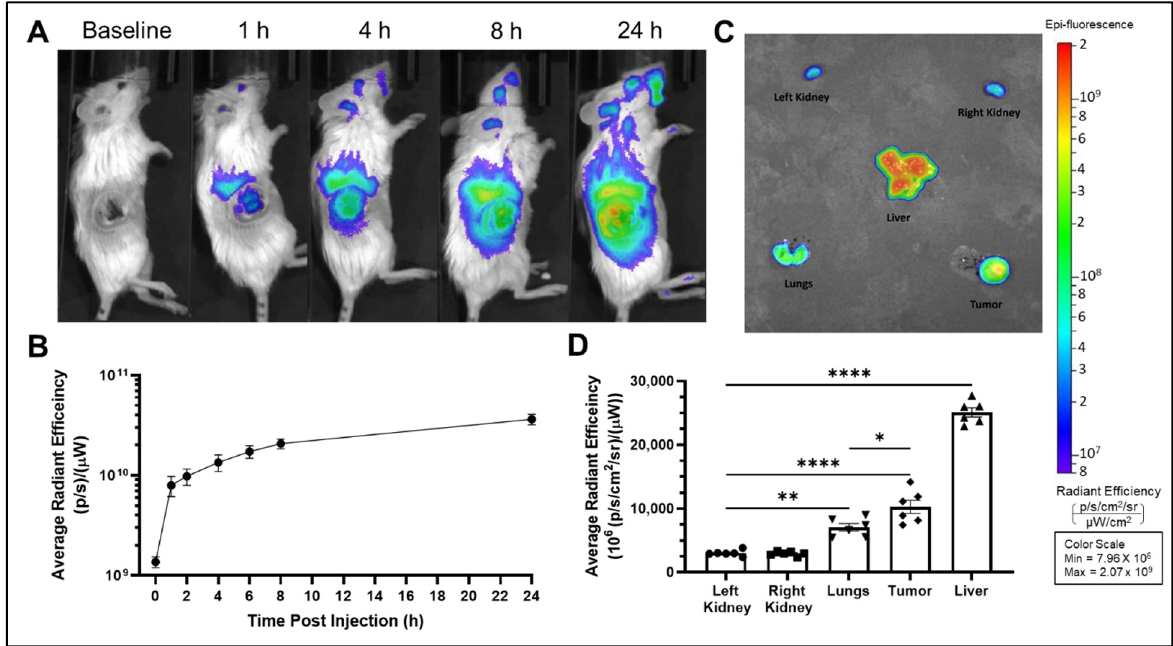
Figure 3. Biodistribution of VivoTrack-labelled RTLs. ( A ) Representative IVIS images of Vivotrack associated fluorescence over the course of 24 h post injection with VivoTrack + SN-38 loaded RTL liposomes. ( B ) Average radiant efficiency in the tumor region of lateral images over 24 h. ( C ) Represen- tative ex vivo IVIS image of VivoTrack associated fluorescence in vital organs and tumor at 24 h post injection of VivoTrack + SN-38 loaded RTL liposomes. ( D ) Average radiant efficiency of vital